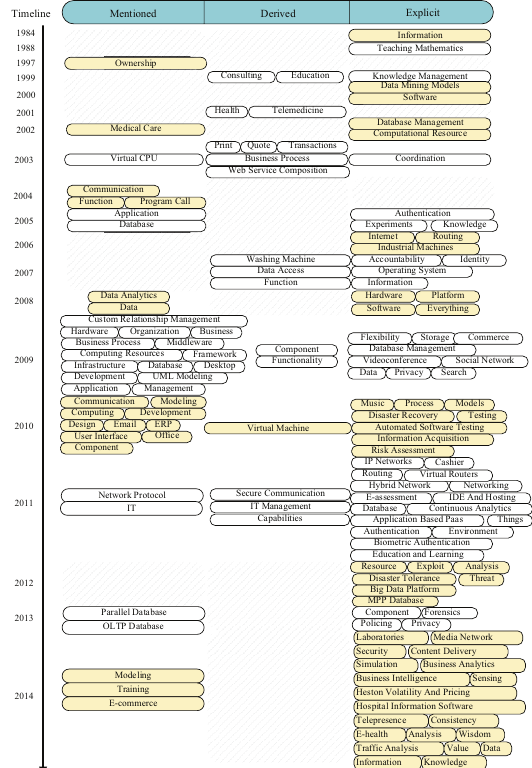
Fig. 2. The appearance of various ”aaS” terms